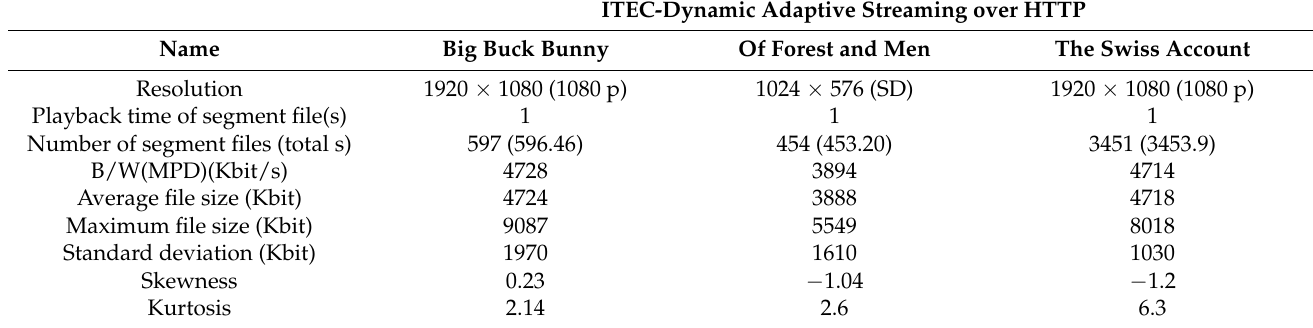
Table 2. Dynamic adaptive streaming over hypertext transfer protocol (DASH) dataset (AVC/H.264). ITEC-Dynamic Adaptive Streaming over HTTP